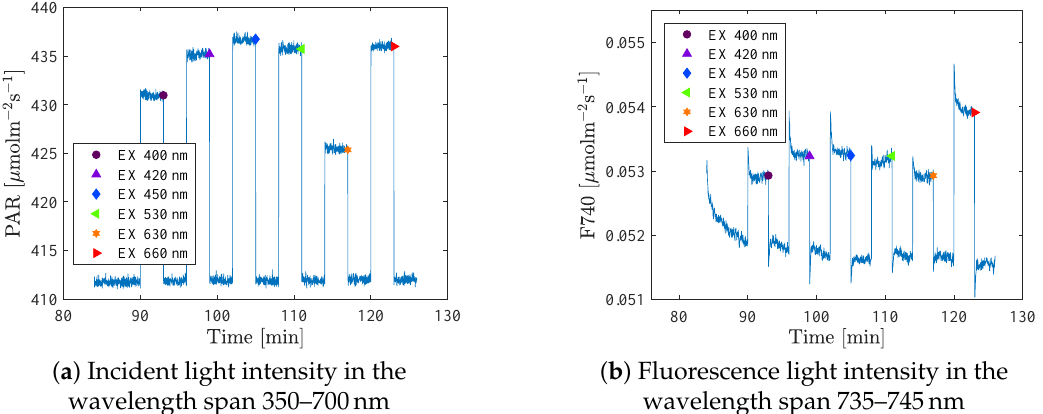
Figure 3. Measurements on lettuce, holding each intensity level at three minutes. ( a ) Incident and ( b ) fluorescence light intensity (µmolm − 2 s − 1 ) vs. time for one background light level (background intensity 500µmolm − 2 s − 1 and spectrum having 85% red light). An excitation step pulse is sequentially added by each LED colour, one at a time. Note that the intensity level measured during the experiment was only about 412 and not 500µmolm − 2 s − 1 . This is because when the light level was determined, no plants were present in the experimental unit and another type of spectrometer was